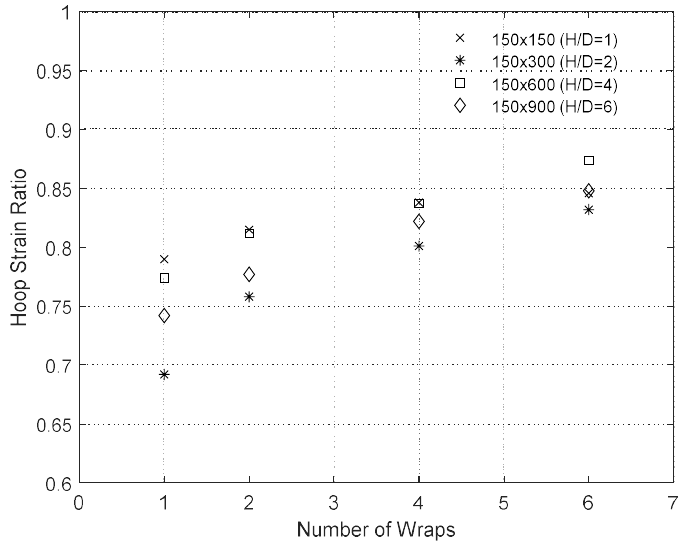
Figure 10. Confinement efficiency factor for various confinement levels and H/D ratios.